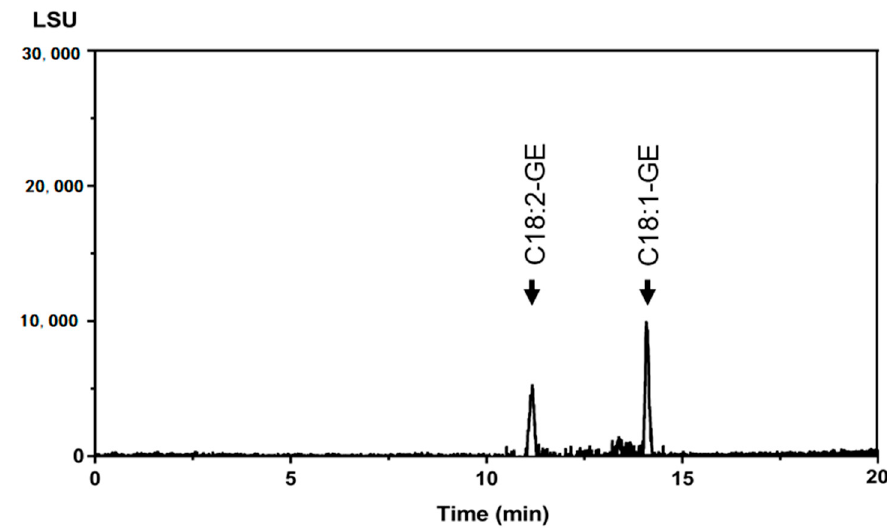
Figure 3. The UPLC-ELSD chromatogram of a rice bran oil sample.